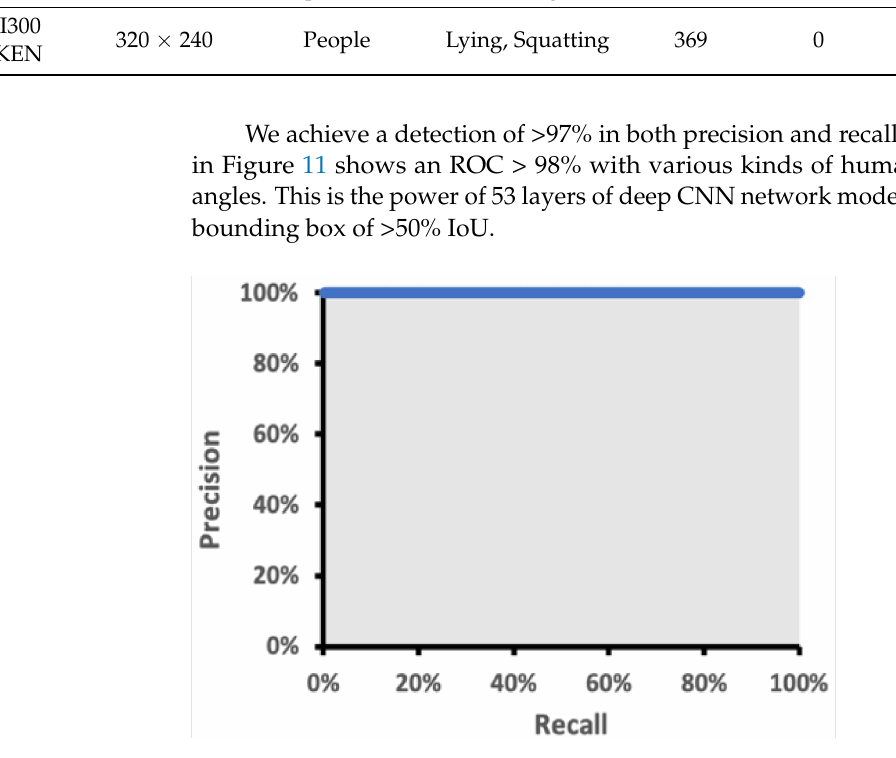
Figure 11. Precision to recall